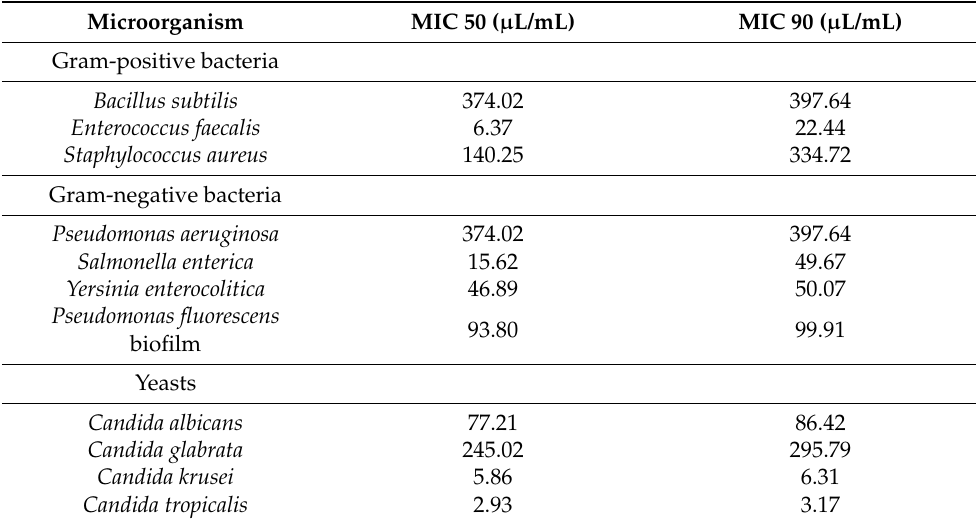
Table 4. Minimal inhibition concentration of Eucalyptus globulus Essential Oil.